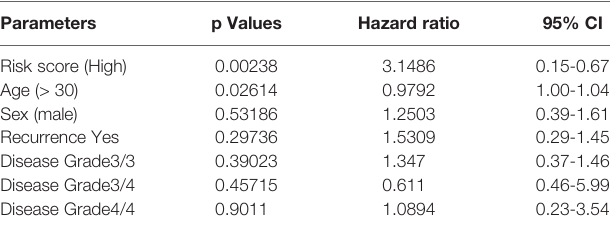
TABLE 3 | Multivariate Cox regression analysis of the risk score with overall survival across the whole